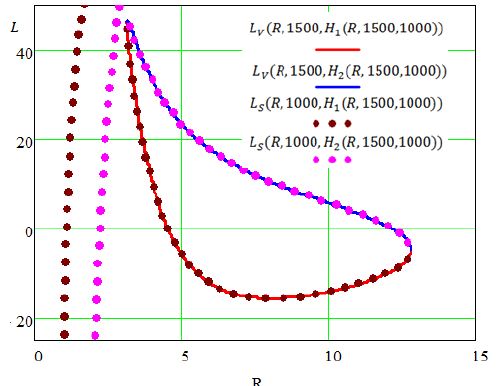
Figure 17. Determination of the range of the permissible values of the parameter for Equation (18).